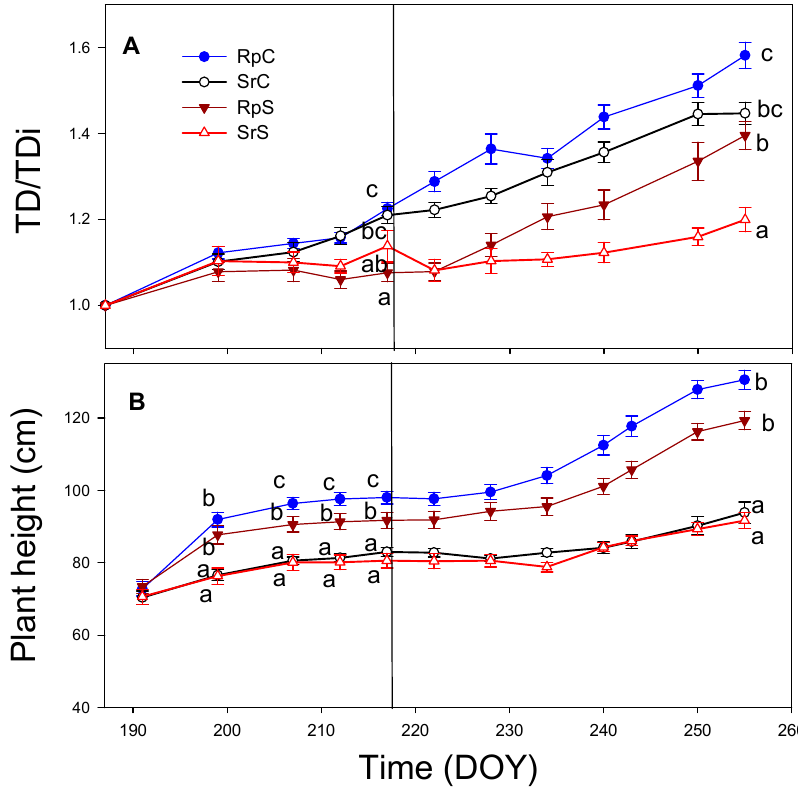
Figure 3. Evolution of trunk diameter as a fraction of the initial value (TD/TDi) ( A ) and plant height ( B ) in P. dulcis plants submitted to different treatments. Values are means + s.e., n = 20. Symbols represent the different treatments: RpC (filled circles; plants grafted under full irrigation), SrC (open circles; self-rooted plants under full irrigation), RpS (filled triangles; plants grafted submitted to water stress) and SrS (open triangles; self-rooted plants submitted to water stress). Different lowercase letters indicate significant differences between treatments according to Duncan 0.05 test. Vertical line indicates irrigation change, the end of the water stress period and the beginning of recovery period.